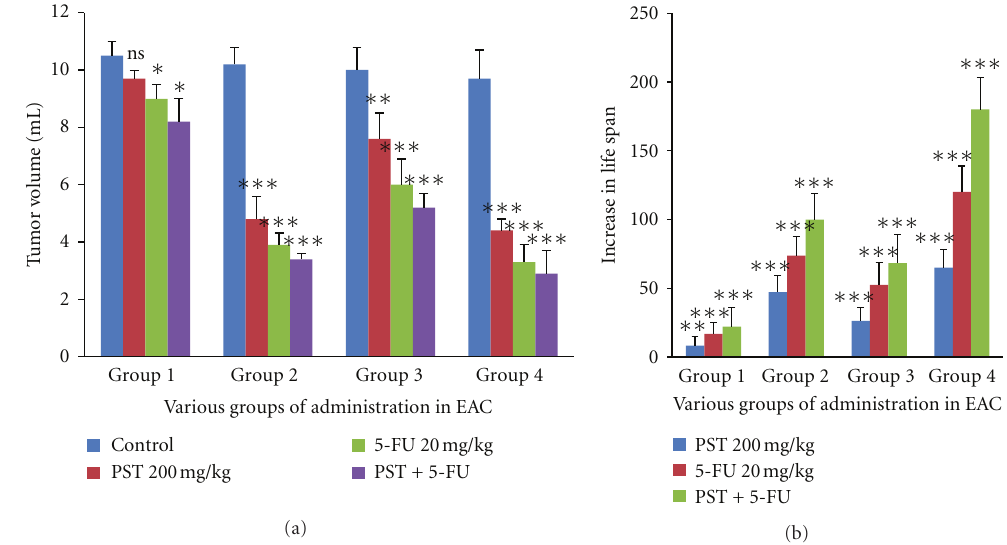
Figure 3: E ff ect of PST001 in Tumor Volume reduction and Increase in life span of various groups administered in EAC tumor bearing mice. Statistically significant di ff erences are at ∗ P < 0 . 05, ∗∗ P < 0 . 01, ∗∗∗ P < 0 . 001; ns is the non-significant, as compared with control group.